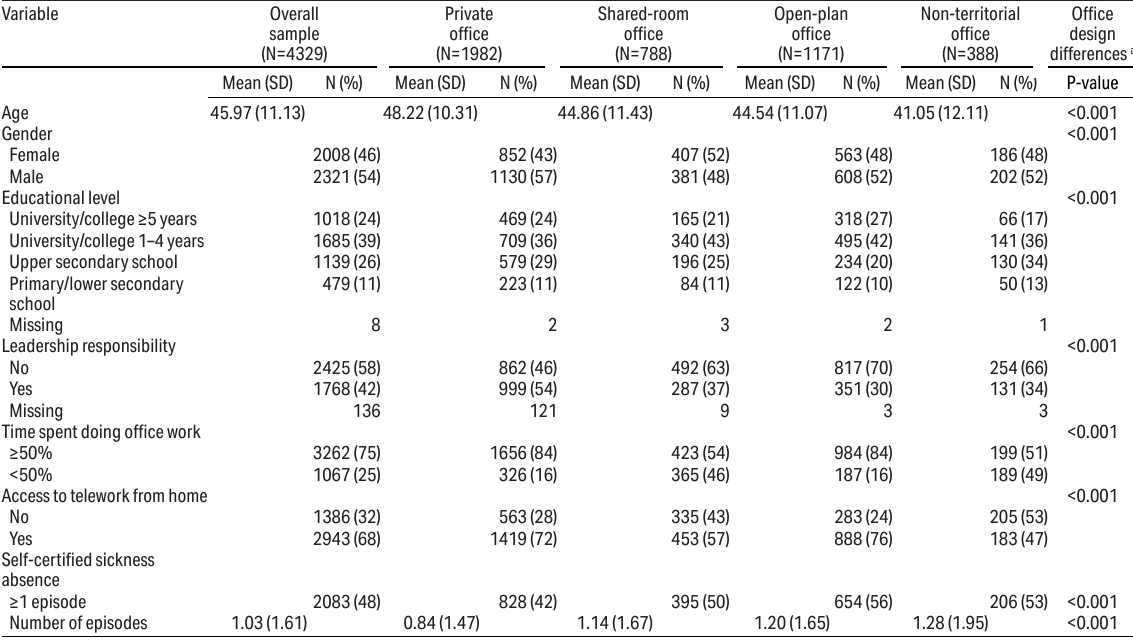
Table 2. Sample characteristics, overall and by office design. [SD=standard deviation.]